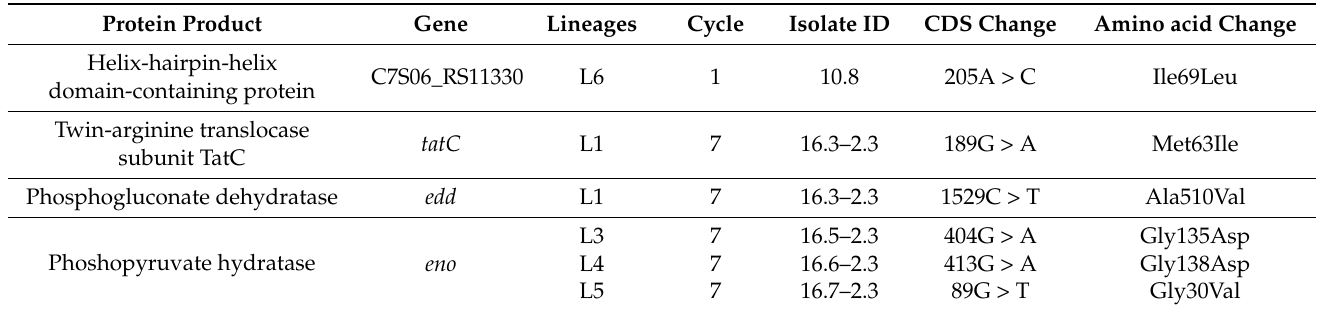
Table 2. List of variants identified in the